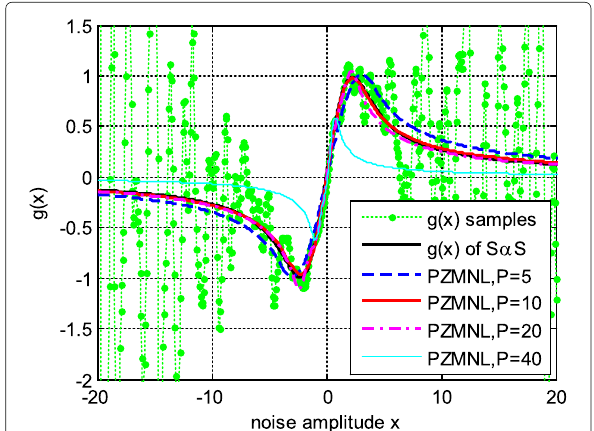
Fig. 2 An example of the PZMNLs in S α S noise for α = 1.5, N = 10